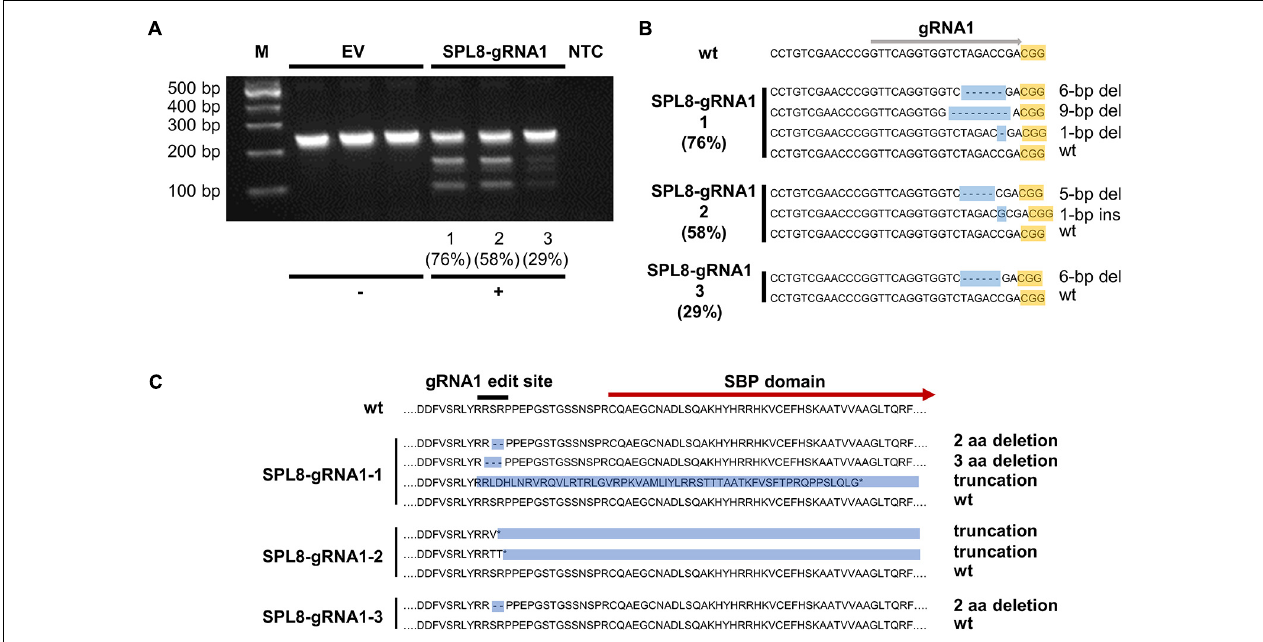
FIGURE 3 | Confirmation of MsSPL8 editing in SPL8-gRNA1 genotypes. (A) T7E1 assay results from three empty vector (EV) control genotypes and SPL8-gRNA1-1, SPL8-gRNA1-2 and SPL8-gRNA1-3 genotypes. While genotypes with no alterations within the MsSPL8 gRNA1 target region show a single band, those with genetic modifications within the gRNA1 target region exhibit multiple bands. Percentages indicate gene editing frequencies determined via GEF-ddPCR. (B) Nucleotide sequences surrounding the MsSPL8 gRNA1 target region from untransformed (wt), SPL8-gRNA1-1, -2 and -3 genotypes as determined by Sanger sequencing. All results are representative of all genetic variants observed within each genotype following the sequencing of 21–33 clones. Percentages indicate gene editing frequencies determined via GEF-ddPCR. (C) Amino acid sequences of MsSPL8 gRNA1 target region from untransformed (wt), SPL8-gRNA1-1, -2 and -3